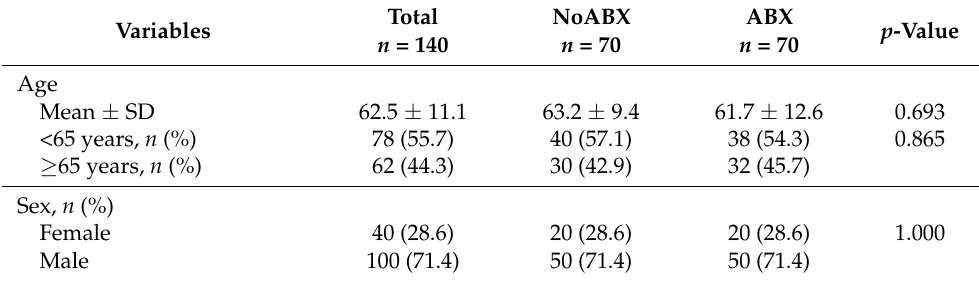
Table 1. Baseline patient characteristics matched by propensity